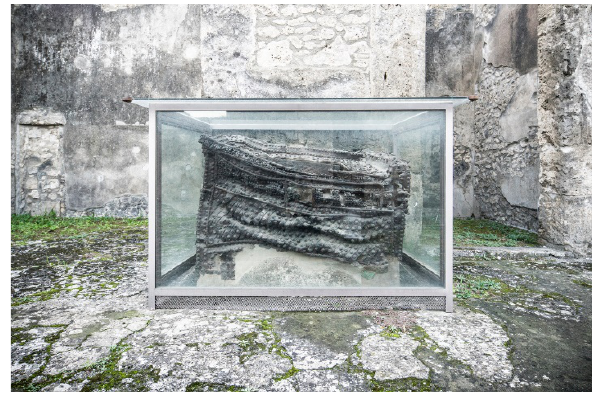
Figure 4. The safe inside the protective case (photo P. Giorgi, from Sassatelli and Giorgi, 2017)